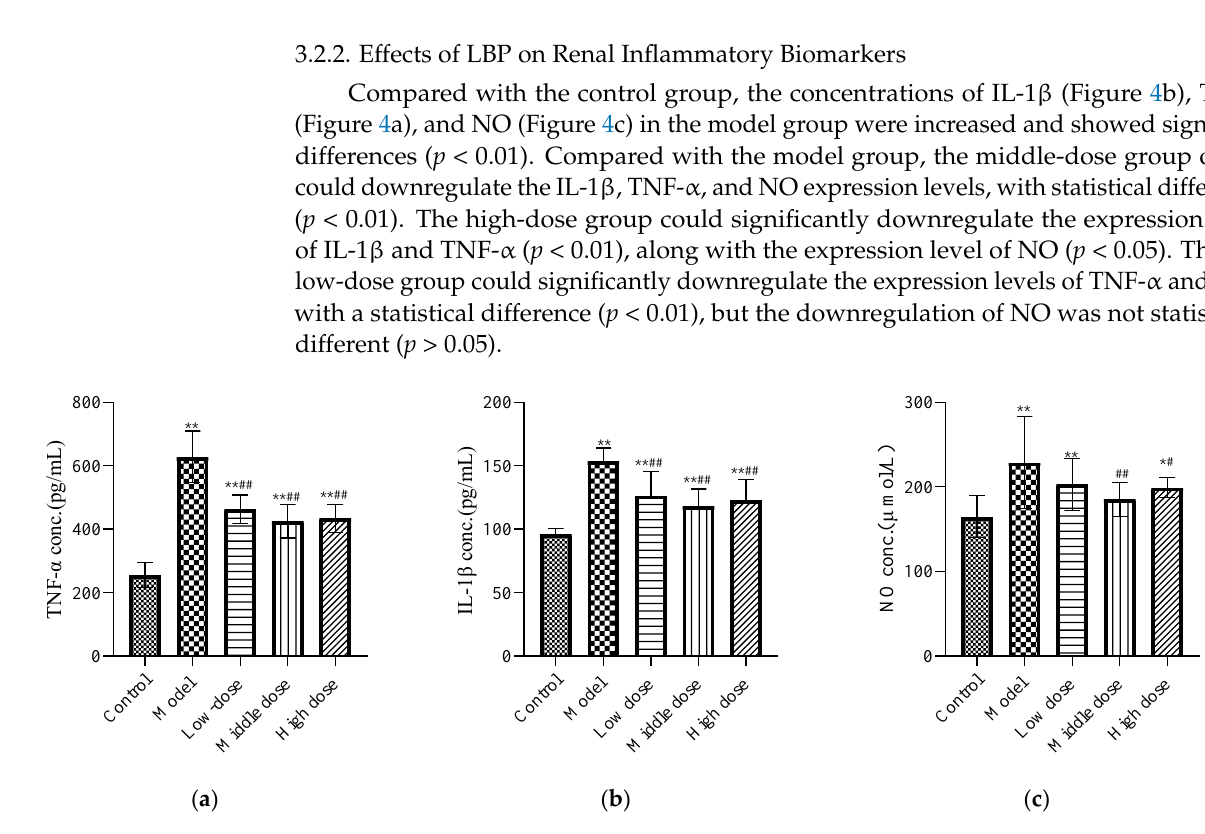
Figure 4. Effects of LBP on renal inflammatory biomarkers. The results are expressed as the mean ±SD, n = 10. * Statistically significant compared to control group, * p < 0.05, ** p < 0.01. # Statistically significant compared to model group, # p < 0.05, ## p < 0.01. ( a ) Expression of tumor necrosis factor-α (TNF-α); ( b ) Expression of interleukin-1β (IL-1β); ( c ) Expression of nitric oxide.